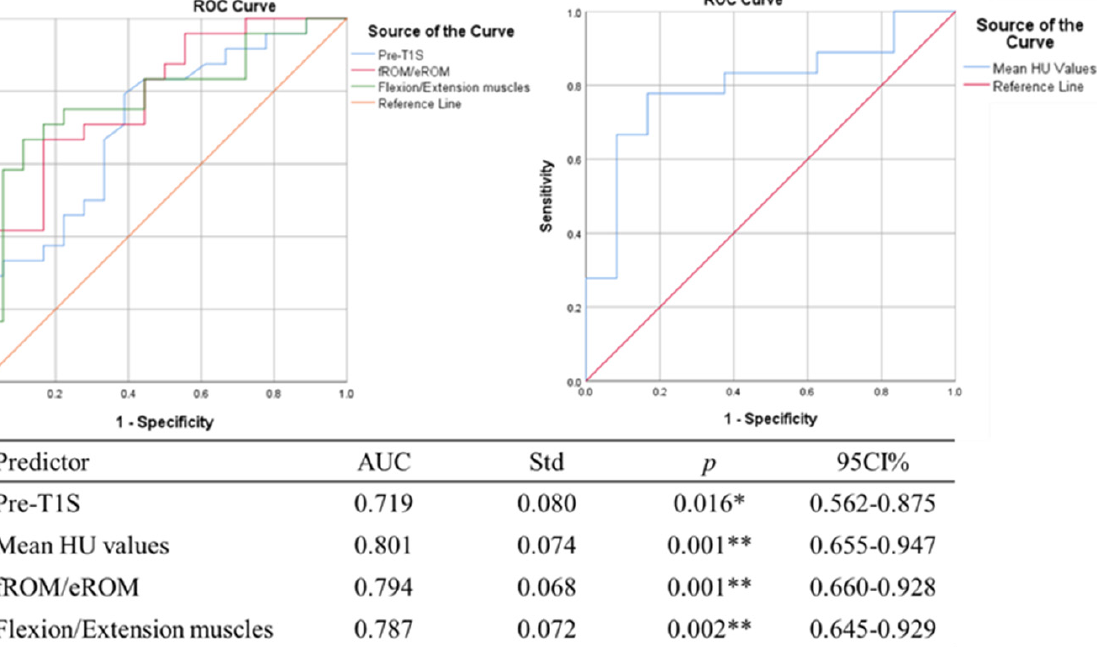
Figure 4. Receiver operating characteristic (ROC) curve for prediction of LCL. Pre, Preoperative; T1S, T1 slope; HU, Hounsfield Units; fROM, ranges of flexion motion; eROM, ranges of extension motion. * p < 0.05, statistical significance. ** p < 0.01, statistical significance. Table 5. Association between various factors and LCL in multiple linear regression analysis.